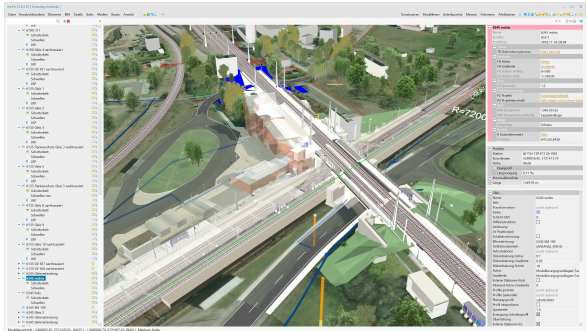
Figure 4. The figure shows the commercial software Korfin© during the joint geometric, topological and semantic analysis of environmental (GIS) and building models (BIM). Figure from (Clemen and Roxin,